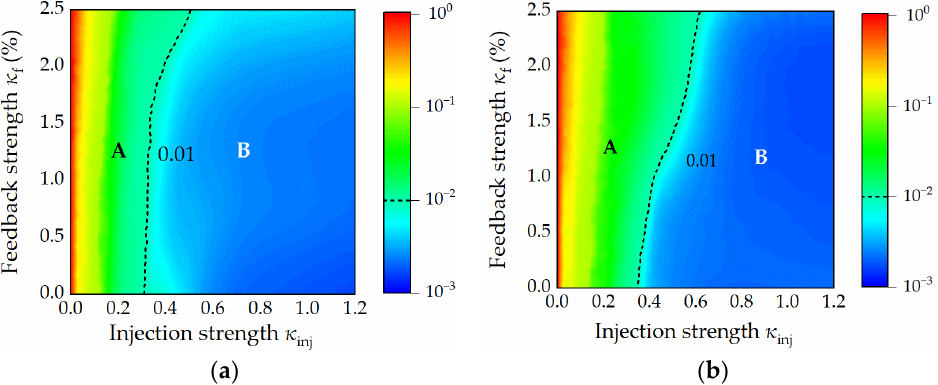
Figure 6. Two-dimensional maps of NMSEs in the parameter space of feedback strength κ f and injection strength κ inj for ( a ) ∆ ν = − 25 GH; ( b ) ∆ ν = 25 GH, with I = 12 I th , and M = 25; the dashed lines in each diagram stand for NMSE =